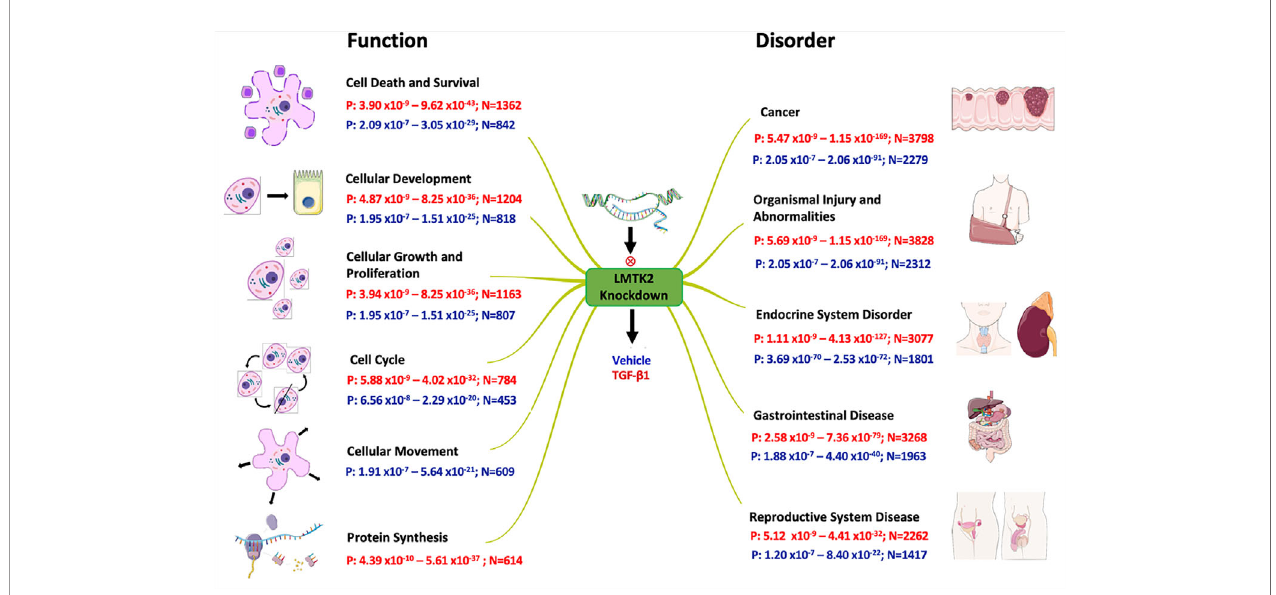
FIGURE 5 | Effects of LMTK2 KD on cellular functions and organismal disorders. Shown are the ranges of p-value (P) and number of affected genes (N) in CFBE41o- cells treated with TGF- b 1 (red) or vehicle control (blue). A different number of genes were affected by LMTK2 KD under the two experimental conditions. LMTK2 KD affected genes regulating protein synthesis only after TGF- b 1 treatment. Genes controlling cell movement were affected by LMTK2 KD only in the absence of TGF- b 1.